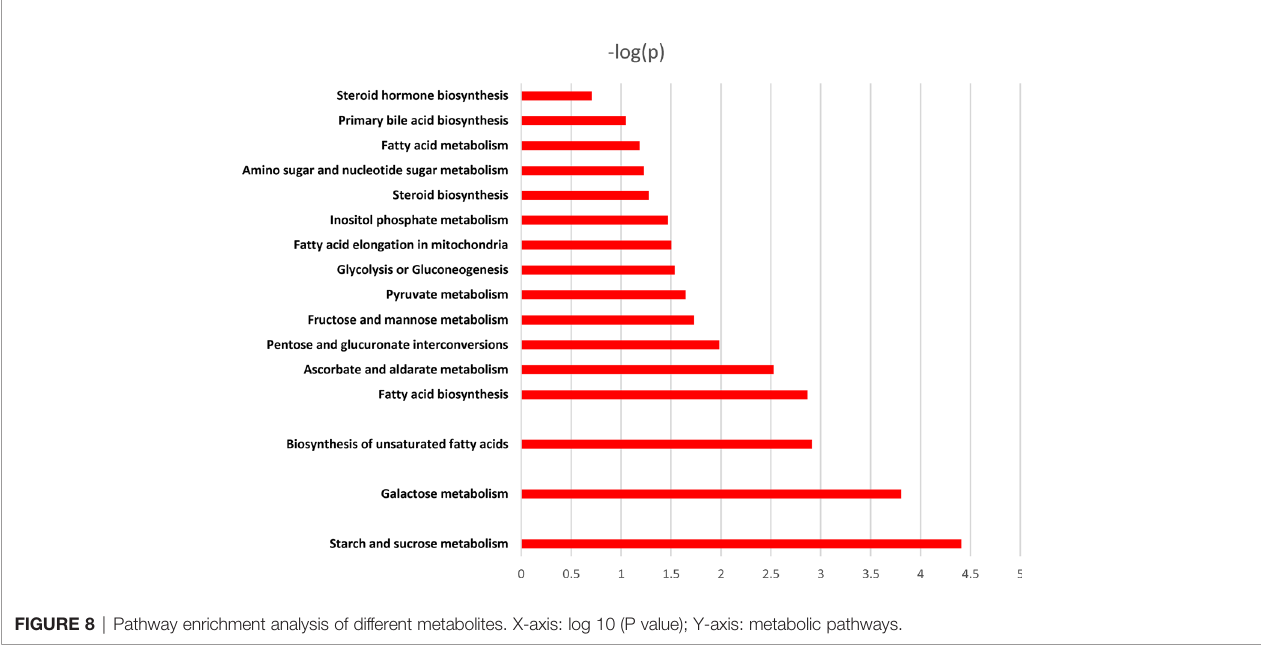
FIGURE 8 | Pathway enrichment analysis of different metabolites. X-axis: log 10 (P value); Y-axis: metabolic pathways.